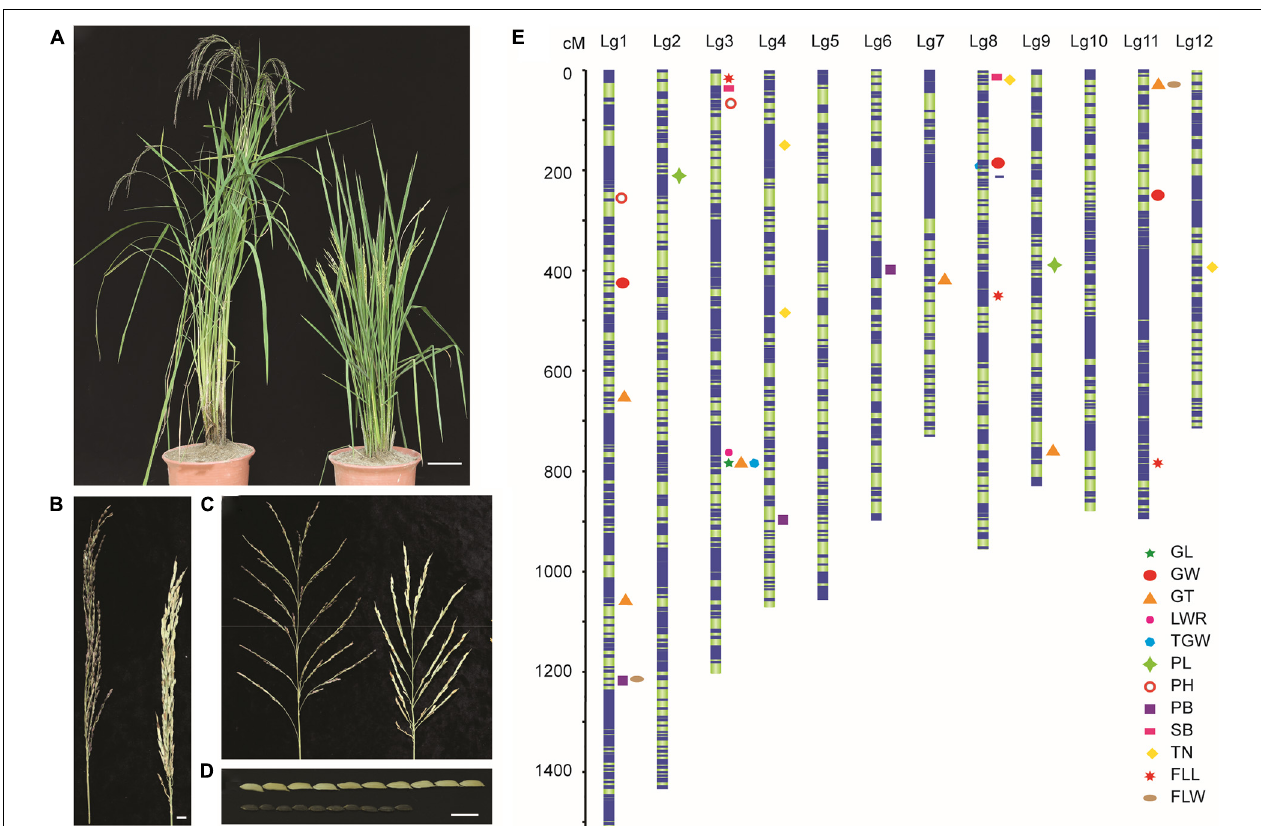
FIGURE 1 | Agronomic characteristics of LM8 and Shen 08S (parents) and the genetic map constructed based on the F 2 population. (A) Plant height of LM8 (right) and Shen 08S (left). Bar = 10 cm. (B) Panicle length of LM8 (right) and Shen 08S (left). Bar = 0.5 cm. (C) Branches of LM8 (right) and Shen 08S (left). Bar = 2 cm. (D) Grain size of LM8 (bottom) and Shen 08S (above). Bar = 1 cm. (E) Genomic locations of 12 agronomic trait associated QTLs are illustrated on the 12 linkage groups. PH, plant height; TN, tillering number; FLL, flag leaf length; FLW, flag leaf width; PL, panicle length; PB, primary branch number; SB, secondary branch number; GL, grain length; GW, grain width; GT, grain thickness; LWR, length to width ratio; TGW, thousand-grain